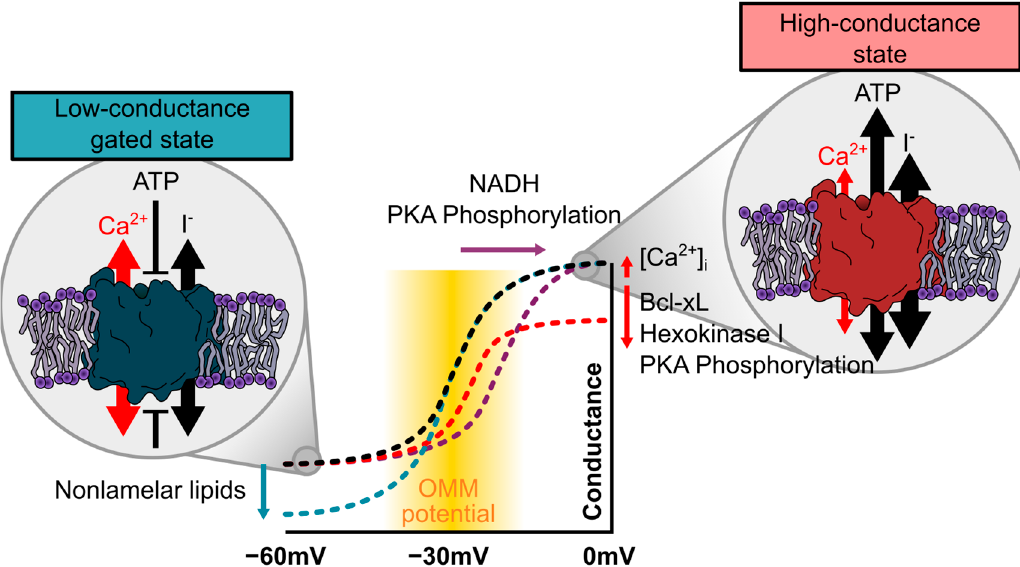
Figure 2. Regulation of voltage-dependent gating of VDAC. While VDAC almost exclusively resides in its anion-selective and metabolite-permeable high-conductance state at neutral potentials, it starts gating within the range of − 20 to − 30 mV (black line), which is well within the predicted range of an OMM potential (yellow zone). Note that the conductance–voltage relation of VDAC is symmetrical, and only the negative side is depicted. At potentials below − 40 mV, it almost exclusively resides in the low-conductance state that is impermeable for ATP but shows a higher permeability of Ca 2+ . Several factors were reported to modulate this voltage–conductance relationship. The phosphorylation status or binding of protein partners such as Bcl-xL or hexokinase were suggested to facilitate channel gating and, thus, induce both a right-shift of the voltage dependence and a reduction in the maximum conductance at potentials close to neutral (red line), while Ca 2+ is suggested to facilitate channel opening and, thus, has an opposite effect. Nonlamellar lipids were demonstrated to promote channel closure at very negative potentials (blue).